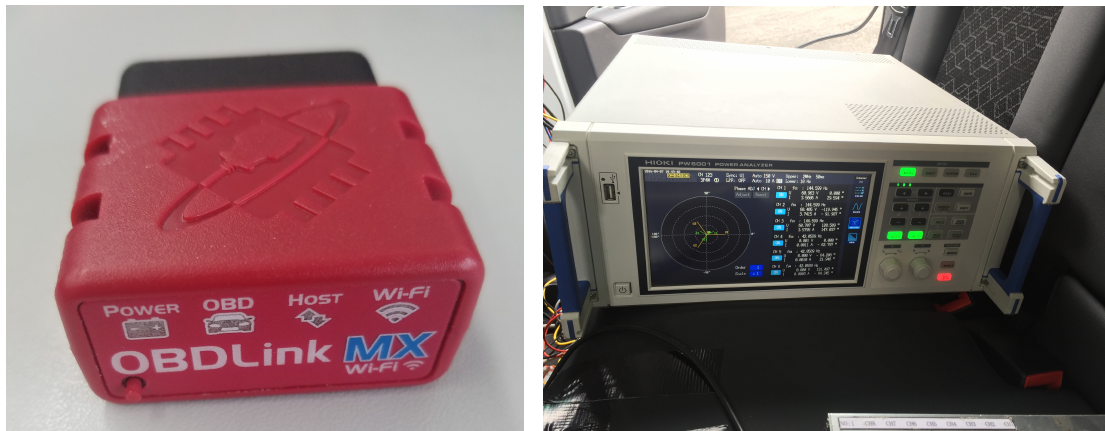
Figure 4. Energy consumption data logging tools: OBD tool ( left ) and power analyzer ( right